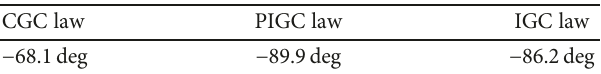
Table 4: Impact angle under the three control laws against a moving